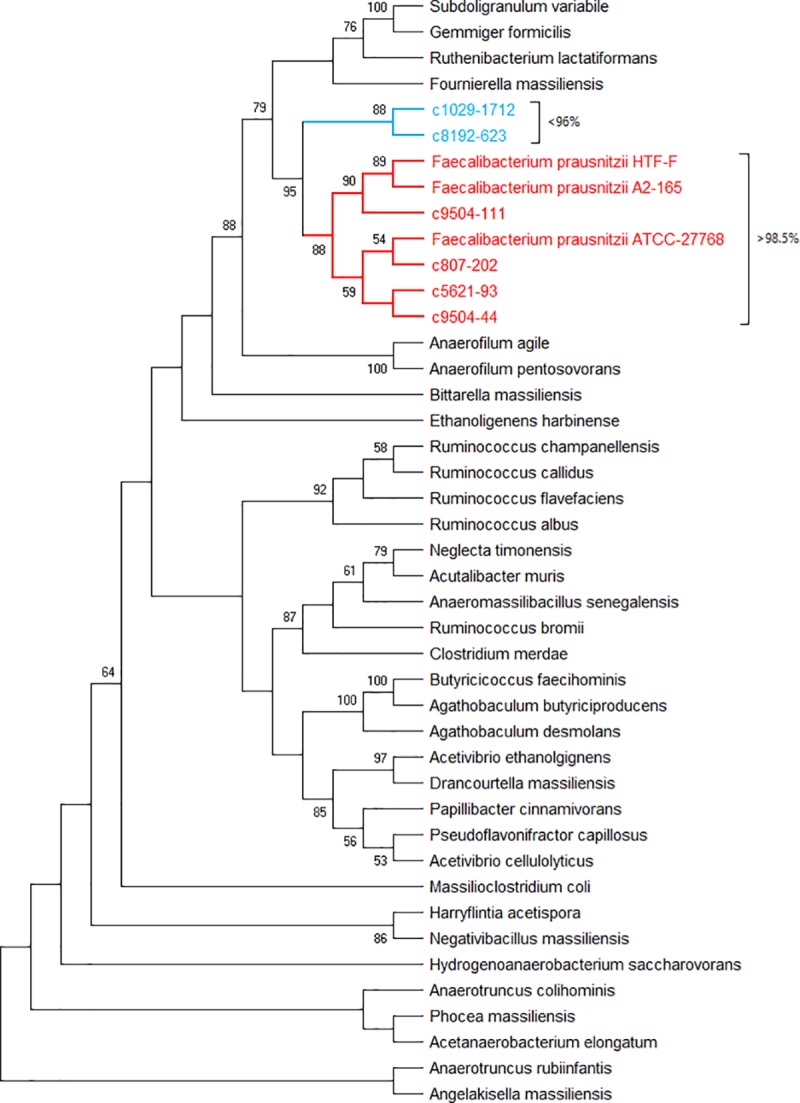
Evolutionary relationships of taxa: Cladogram of Ruminococcaceae 16s v4 sequences.The evolutionary history was inferred using the Neighbor-Joining method. The optimal tree with the sum of branch length = 1.5 is shown. The percentage of replicate trees in which the associated taxa clustered together in the bootstrap test (500 replicates) are shown next to the branches if >50%. The tree is drawn to scale, with branch lengths in the same units as those of the evolutionary distances used to infer the phylogenetic tree (number of base substitutions per site). The distances were computed using the Maximum Composite Likelihood method. This analysis involved 43 nucleotide sequences. Evolutionary analyses were conducted in MEGA X. Centroids with >98.5% sequence identity to the reference strain F. prausnitzii ATCC-27768 are shown in red, those with <96% identity to the reference are in blue.